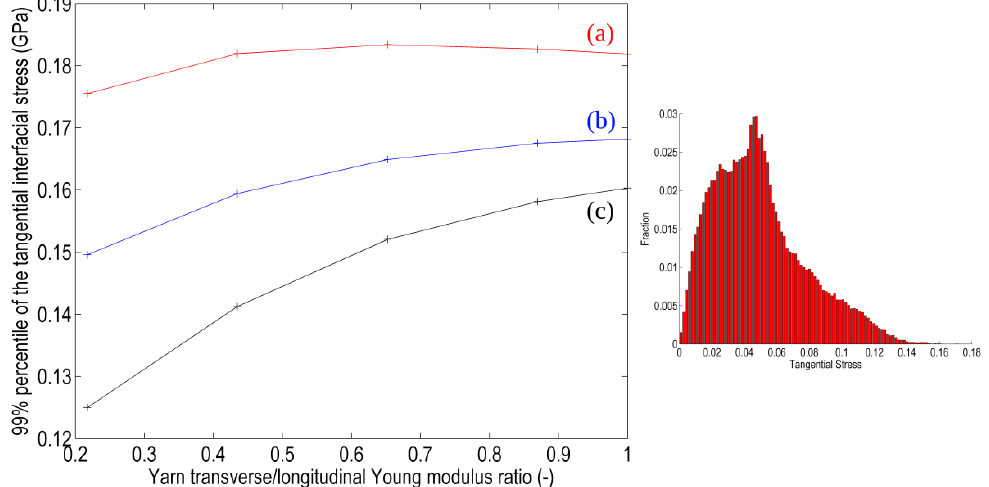
Figure 17. Maximal interfacial tangential stress present in the RVE as a function of the anisotropy ratio in the transversely isotropic behavior of yarns for the three RVEs: ( a ) 2.5Da RVE with non-alternating binders; ( b ) 2.5Db RVE with alternating binders; and ( c ) fully 3D RVE with purely vertical (weft) binders.